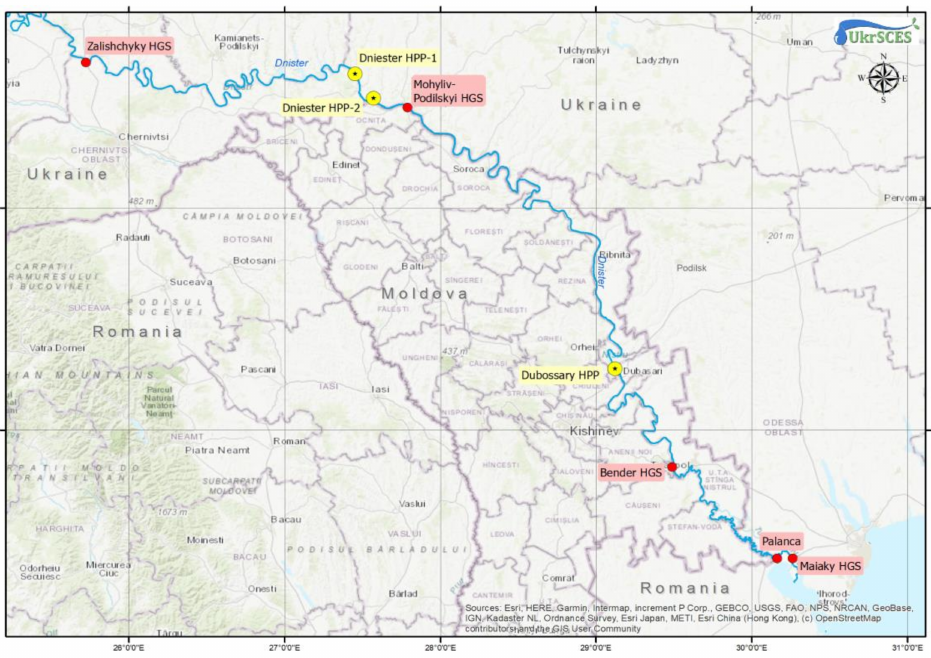
Figure 1. Map of the investigated area of the Lower Dniester (HPP = hydropower plants; HGS = hydrological gauging